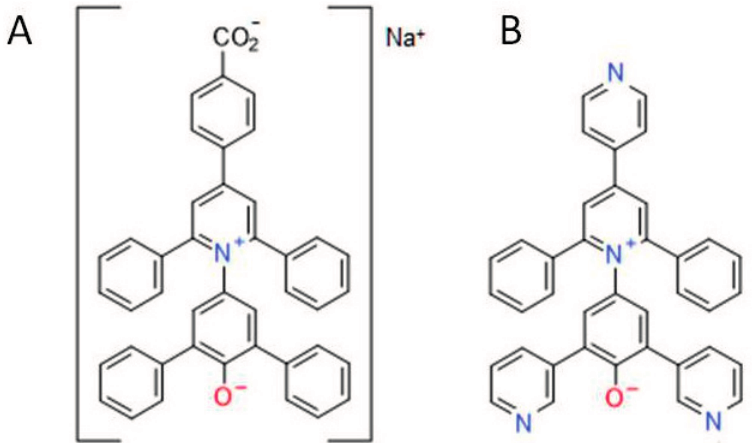
Figure 6. Molecular structure of two Reichardt’s dyes used in this study. ( A ) Carboxylated betaine dye used in partition experiments; ( B ) 4-[2,6-Diphenyl-4-(pyridine-4-yl)pyridinium- 1-yl]-2,6-bis(pyridine-3-yl)phenolate, also known as Reichardt’s pyridyl-substituted E T